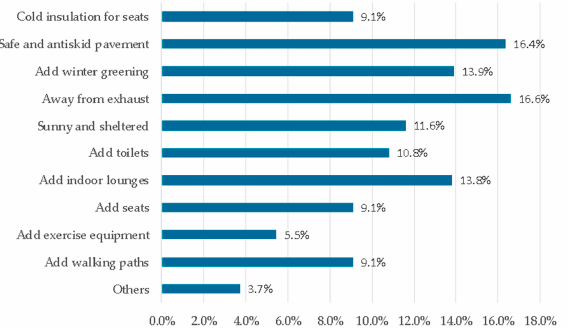
Figure 4. Factors promoting consistent exercise in the green spaces.